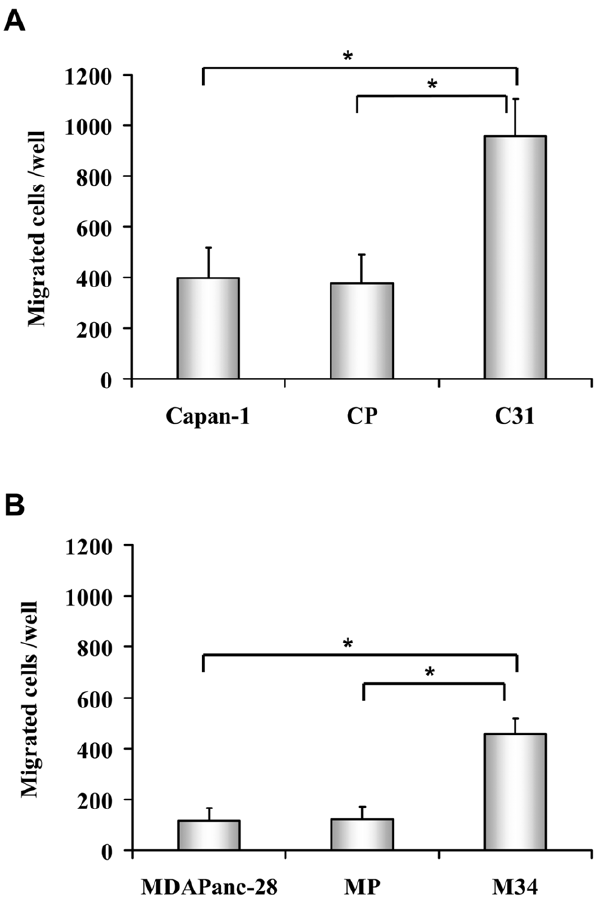
Figure 5. Cell migration assay. Capan-1 variant cells (Capan-1,CP and C31) (Figure 5A) and MDAPanc-28 variant cells (MDAPanc-28, MP and M34) (Figure 5B) were seeded onto 8 m m-pores-Type I-Collagen coated inserts, placed on top of wells containing DMEM-1% FBS and incubated at 37 u C (6 h for Capan-1 model and 18 h for MDAPanc-28 model). Non-migrated cells were eliminated and migrated cells fixed, stained and counted. Results are expressed as migrated cells per well. Data represents the mean 6 SD of the values obtained in 3 separate experiments, (n=9). * Significantly different ( P , 0.001 ).